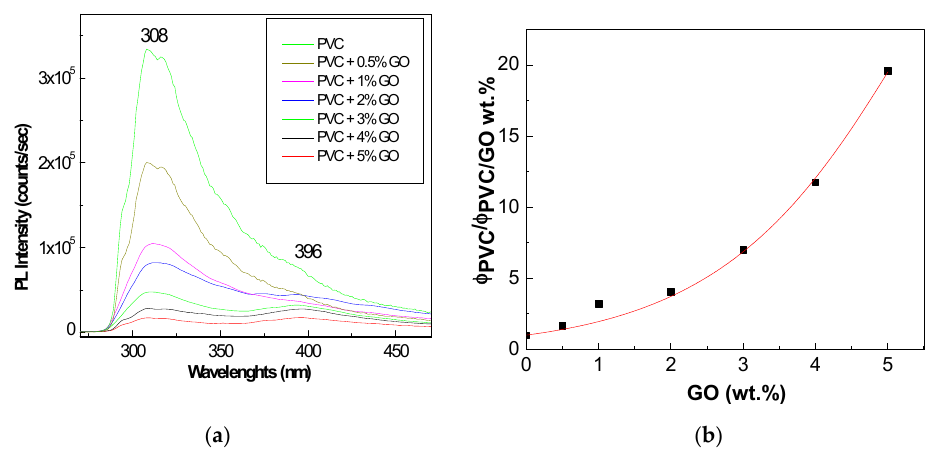
Figure 6. Photoluminescence (PL) spectra of PVC and composites with GO when the GO sheet concentration is equal to 0.5 wt.%, 1 wt.%, 2 wt.%, 3 wt.%, 4 wt.%, and 5 wt.% ( a ). Dependence of the ratio between PL band intensity of PVC spheres and PVC/GO composite with the concentration of GO sheets ( b ).